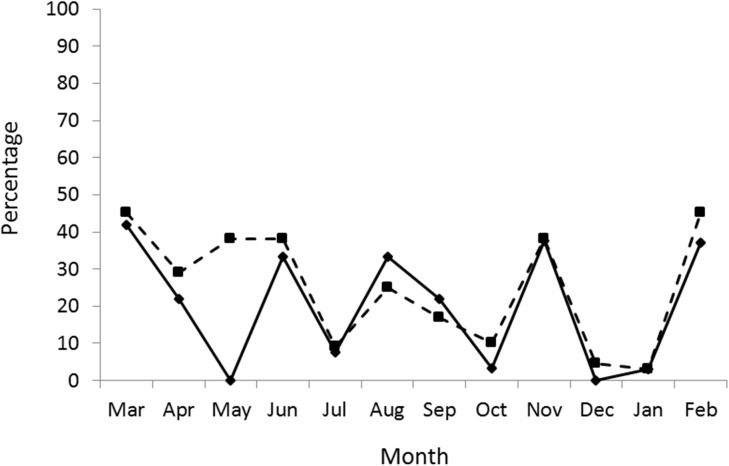
The proportion of females by month in oestrus.The proportion of females in each month in oestrus, as determined by histological examination of the endometrium (solid line) and the vaginal epithelium (broken line).